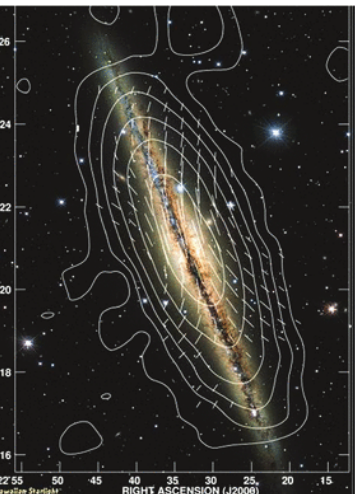
Figure 12. Total intensity contours of the λ 3 . 6cm radio contin- uum emission from the edge-on spiral galaxy NGC891 observed with the E ff elsberg 100m radio telescope. The background is an optical image from the CFHT. The small bars show the polar- ization half-vectors rotated by 90 ◦ to trace the orientation of with no correction for Faraday rotation [42]. Copyright: MPIfR